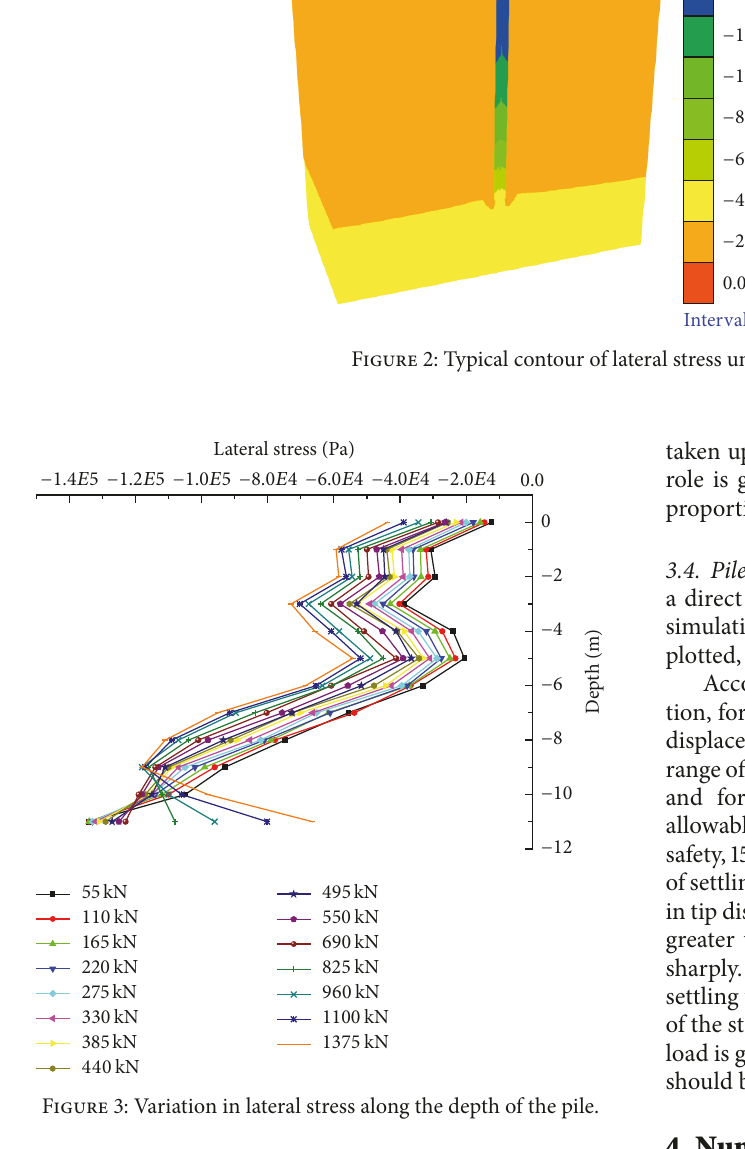
friction stresses were calculated; these are shown in Figures 6 and 7,